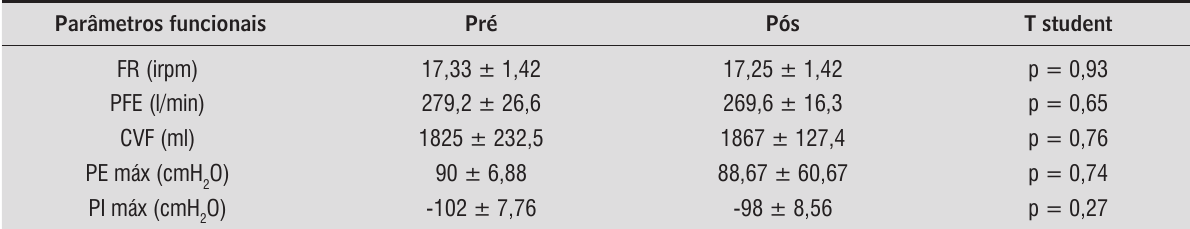
Tabela 2 - Parâmetros funcionais mensurados no pré e no pós-posicionamento dos membros superiores, no grupo